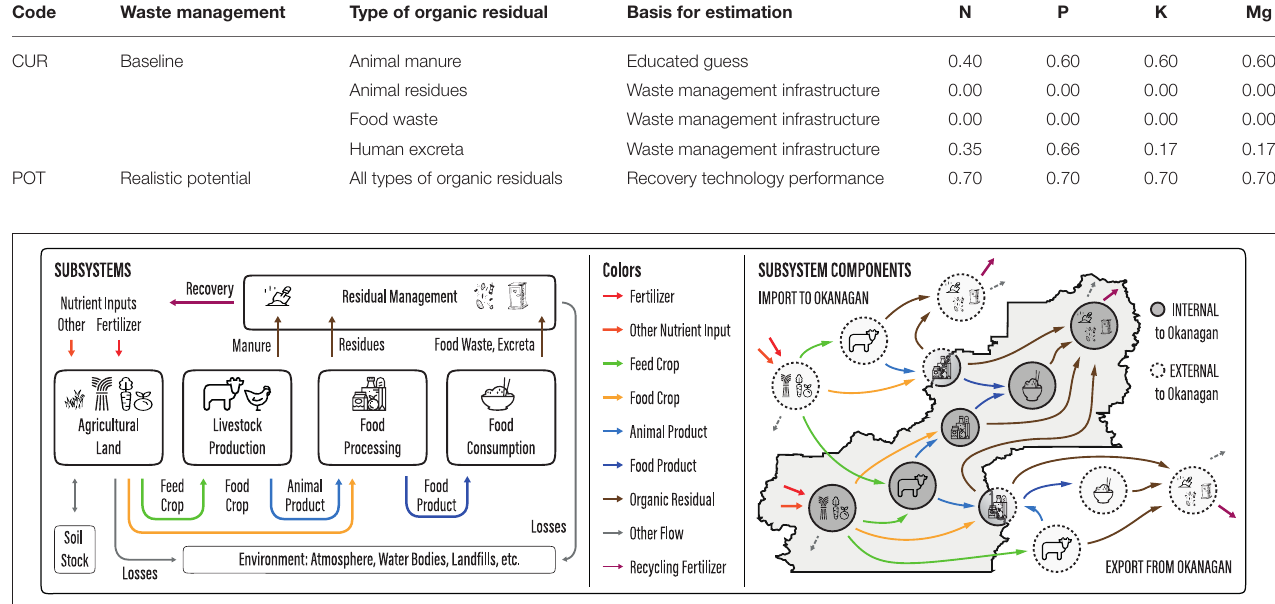
FIGURE 2 | Structure of the analysis. Functionally, the analysis encompasses five subsystems that are connected to one another as shown in the left part of the figure. For each subsystem, spatially, the analysis distinguishes one component internal and one external to the Okanagan, which is shown in the right part of the figure. Note that, for clarity, the external component is split into two parts: one relates to imports into and one to exports from the Okanagan. Figure adapted from Harder et al.